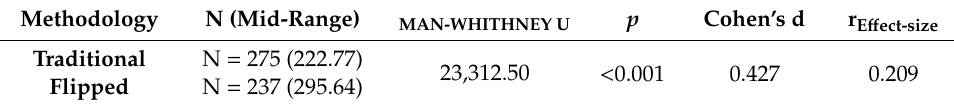
Table 2. Class attendance depending on educational methodology.